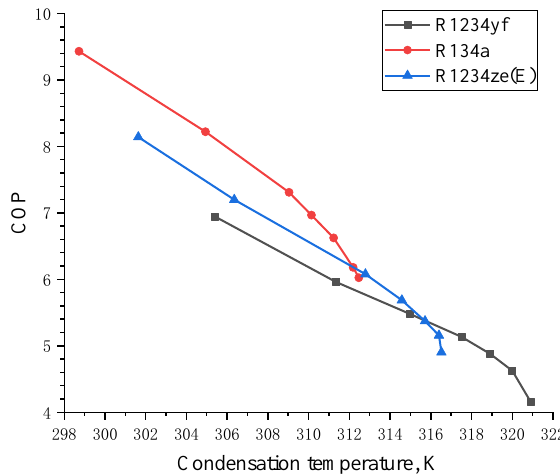
Figure 8. COP at different condensation temperatures.